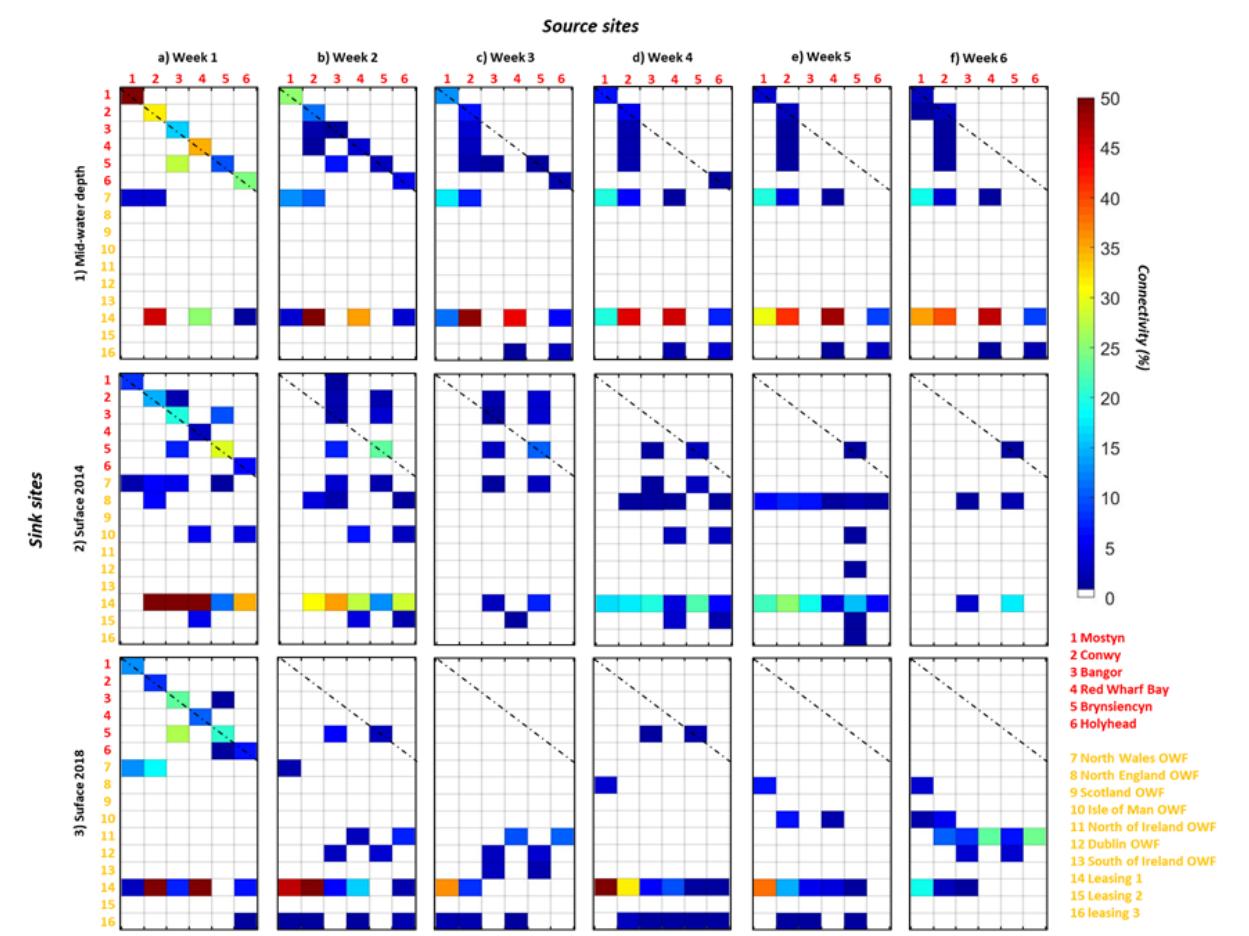
Fig. 6. Connectivity matrices for particles when released from 6 sources site (1-6) at: 1) midwater depth; 2) surface during March and April in 2014; and 3) surface during March and April in 2018. Results are presented per week: (a) week 1; (b) week 2; (c) week 3; (d) week 4; (e) week 5; and (f) week 6. Connectivity between larvae from a source (column) with a sink (row) is highlighted by colour scale with high connectivity in red, low connectivity in blue and no connectivity in white. Self-recruitment (e.g. retention within the release site) is indicated by cells that cross the diagonal dashed line. Sites are colour coded as: red = source and sink sites and orange = sink sites